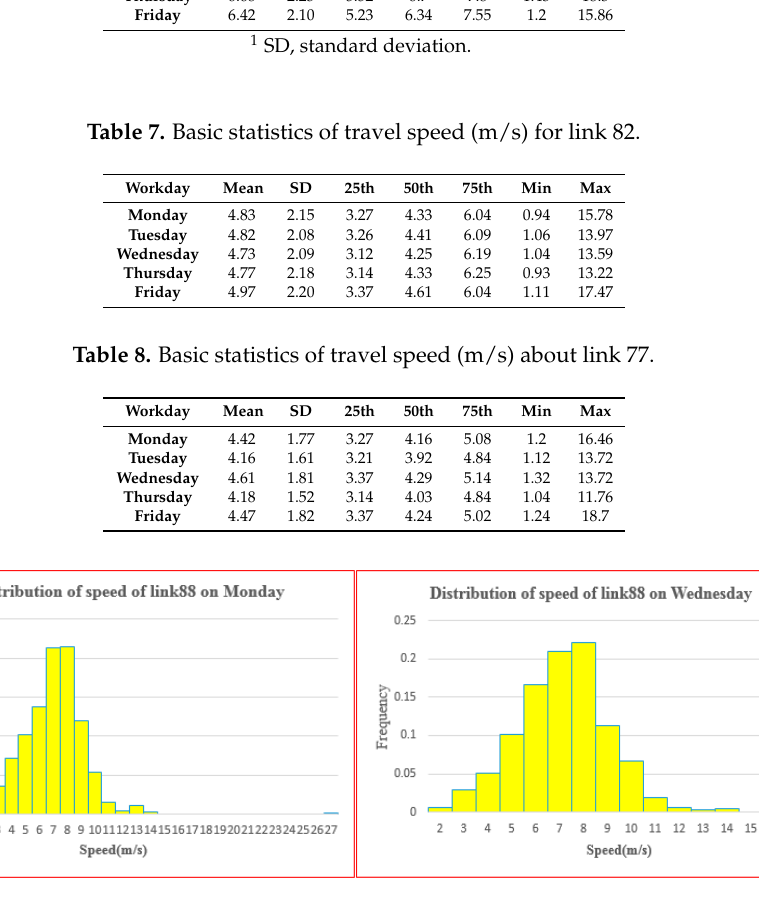
Figure 7. Distribution of speeds among the observations of link 82 on Monday and Wednesday. Figure 8. Distribution of speeds among the observations of link 77 on Monday and Wednesday.